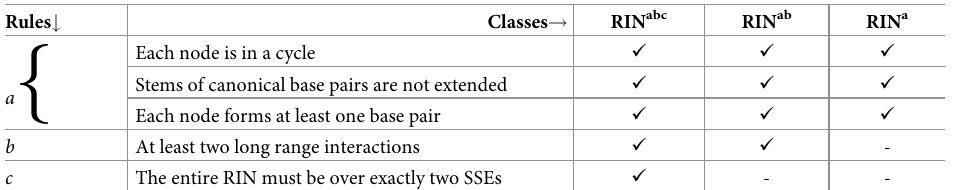
Table 1. Rules and RIN classes. Summary of the relation between the rules and the three RIN